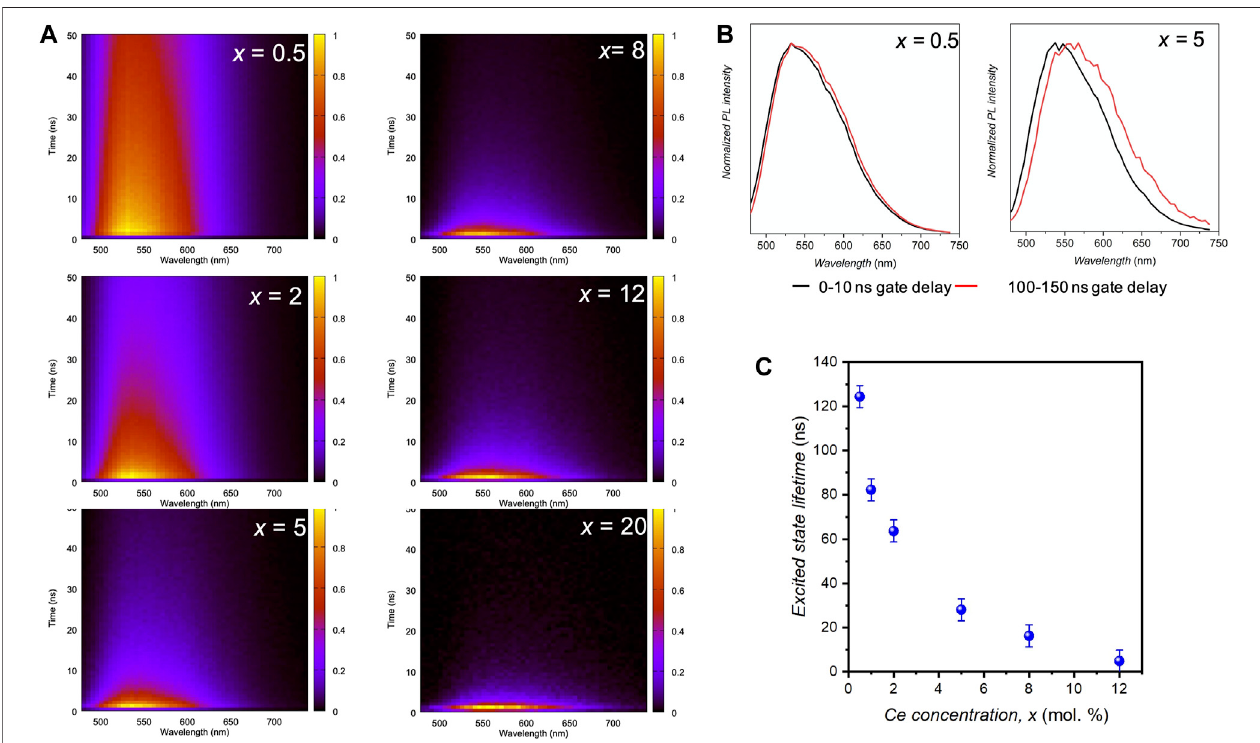
FIGURE 5 | (A) 2D maps showing the PL decay over time. (B) Time-resolved PL spectra for two delay gates (0 – 10 ns and 100 – 150 ns) for x (cid:1) 0.5 mol.% and 5 mol.%. (C) Excited state lifetime at 550 nm (exc. 457 nm) as a function of the cerium doping concentration, x .